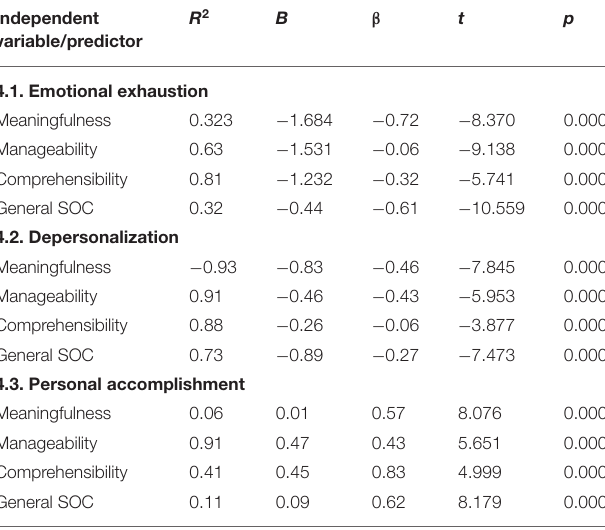
TABLE 4 | Results of linear regression analysis of relation between SOC and